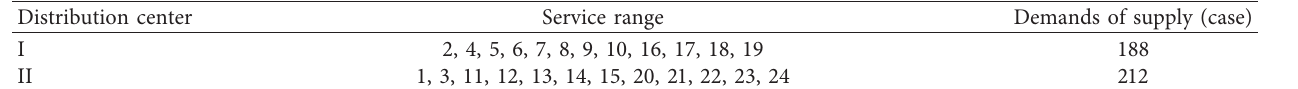
Table 4: Subgraph division in the control solution.